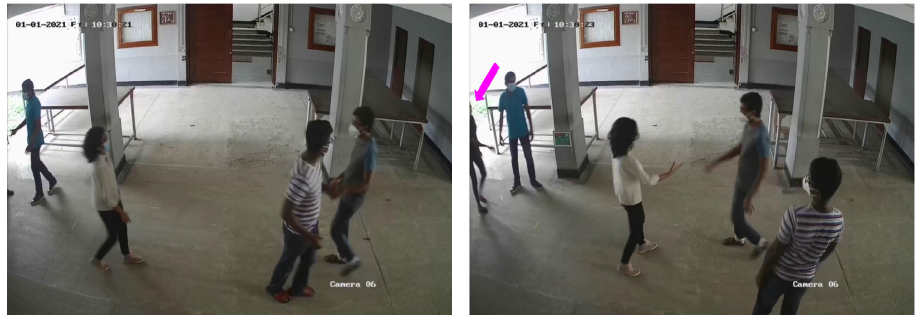
Figure 18. Edge case 1 threat level interpretations. System threat evaluation output—Increases, Human expert opinion